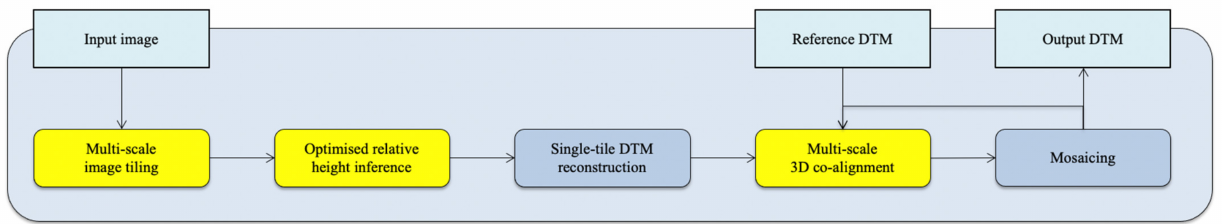
Figure 4. Flow diagram of the proposed MADNet 2.0 single-image DTM estimation system showing the same details as the flow diagram of the MADNet 1.0 system, in Figure 3, with changed components indicated in yellow. N.B. lighter coloured boxes represent the inputs and/or